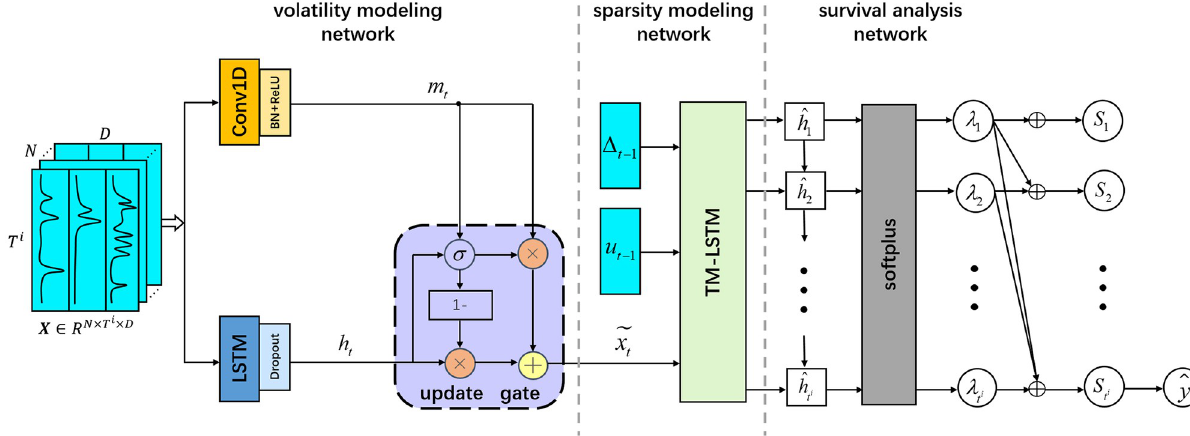
Fig 1. The architecture of SAVSNet. The model consists of three major components, namely the volatility modeling network, the sparsity modeling network, and the survival analysis network.